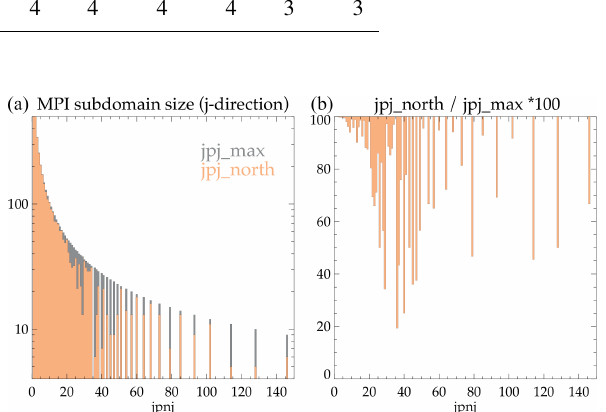
Figure 1. Example of ORCA025 domain decomposition along the j direction (1021 points): (a) j size of the largest MPI subdomains ( jpj max , in grey) and of the northern MPI subdomains ( jpj north , in orange) according to the optimum number of MPI subdomains in the j direction ( jpnj ); (b) ratio jpj north / jpj max in